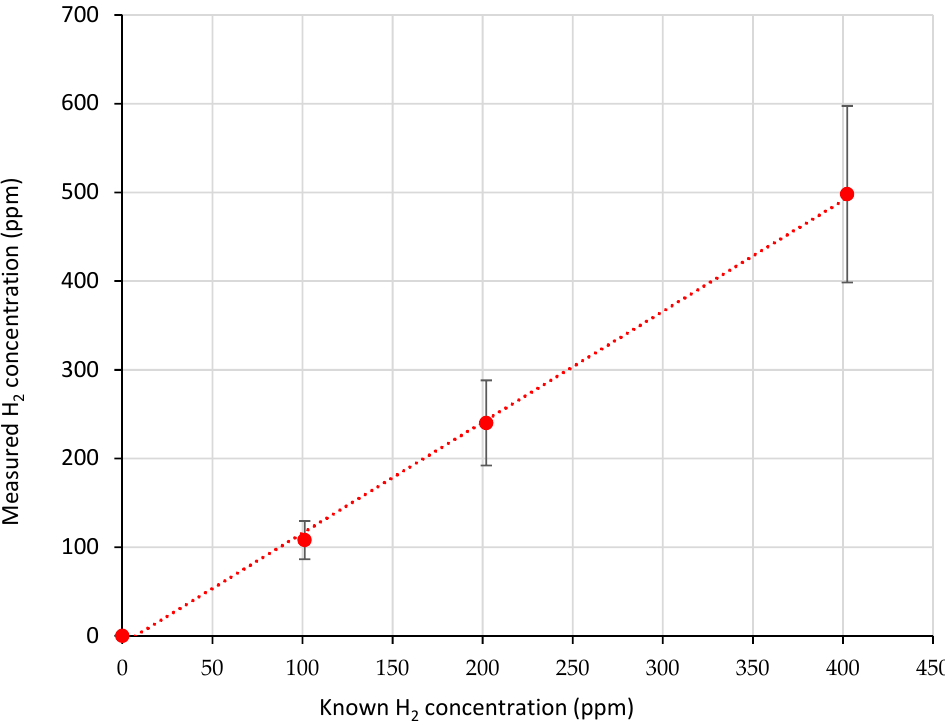
Figure 4. Measured hydrogen concentration (GA5000) vs. known hydrogen concentration (mass flow controllers) for experiments containing approximately 10,000 ppm methane (experiments 17–20).